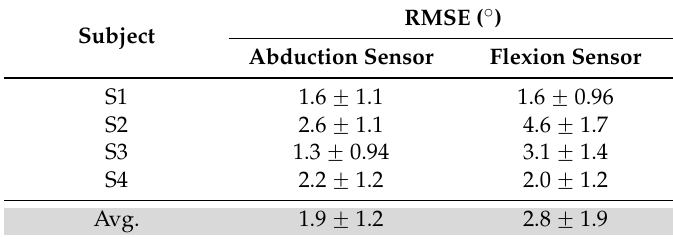
Table 3. The normalized root mean square error (RMSE) of calibrated sensor values.